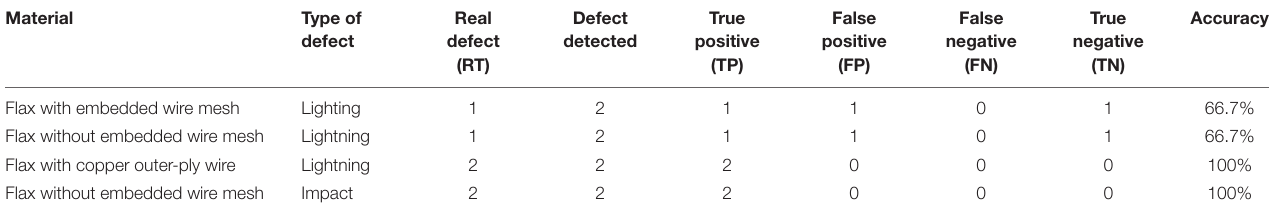
TABLE 3 | Camera thermoIMAGER TIM 200 detection performance.